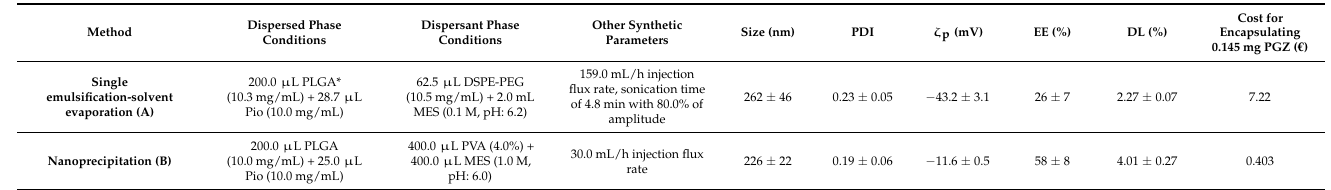
Table 3. Table 3. Summarized results on Pioglitazone-loaded PLGA nanoparticles synthesis; the best compro- mise formulations are